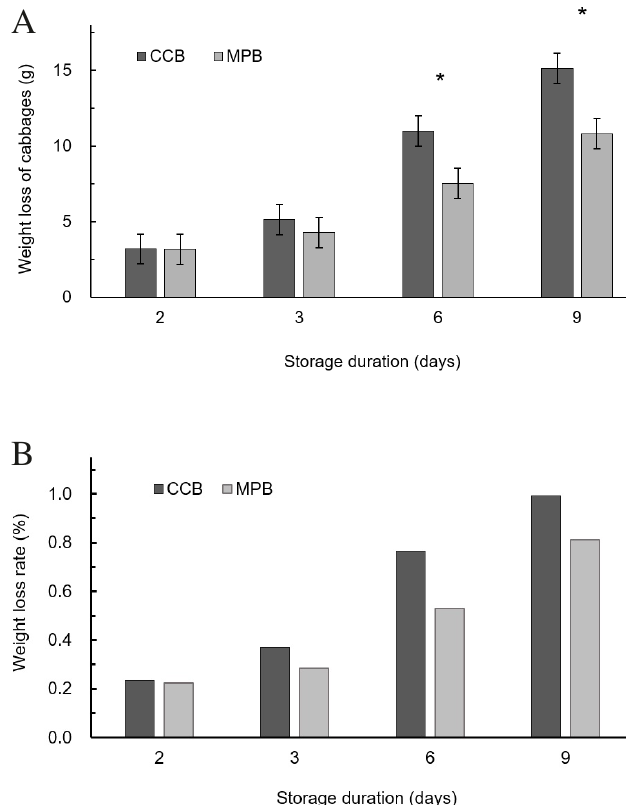
Fig. 4: Effect of storage in different corrugated boxes on weight loss from cabbages. (A) Weight loss from cabbages (g) and (B) weight loss rate (%) for cabbages stored in conventional corrugated boxes (CCBs) and moisture-proof corrugated boxes (MPBs). Error bars indicate standard deviations (n = 5). Asterisks indicate significant differ - ences by Welch’s t -test ( p < 0.05).